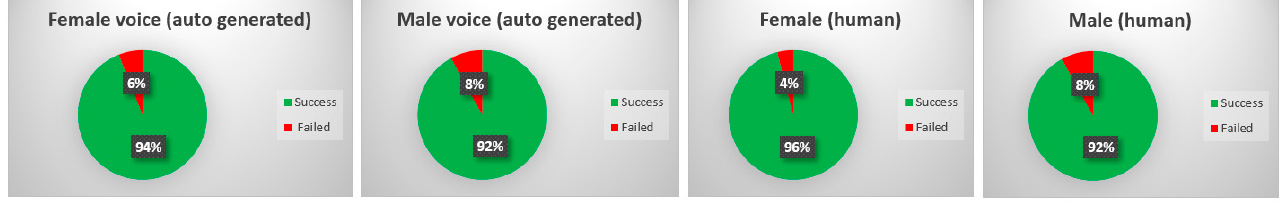
Figure 15. Voice sample simulation results.